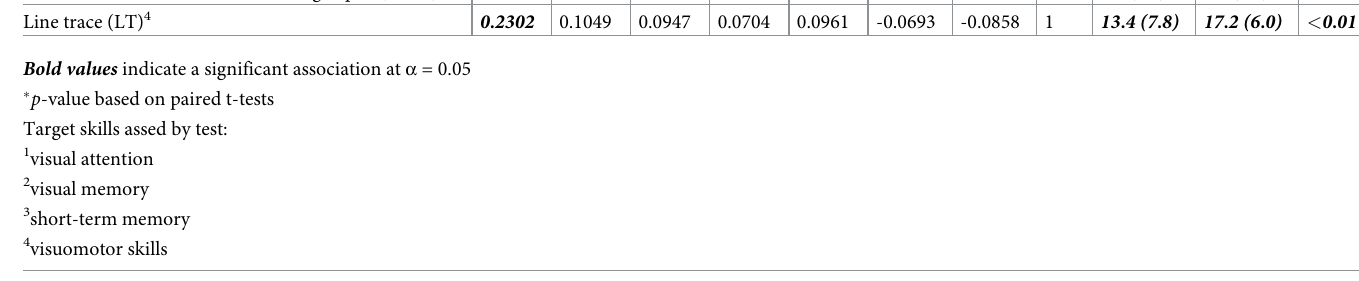
Results from pairwise tests of correlations between cognitive test scores and results from the paired t-tests of the association between test score and visit day are shown in Table 2. Most tasks were significantly correlated with at least one other task included in the battery of cogni- tive tests. Students achieved significantly higher scores on the second visit compared to the first visit for six of the eight cognitive tests, regardless of treatment condition. Table 2. Correlation matrix of cognitive test scores’ pairwise correlation coefficients and univariable associations between visit day and mean (standard devation) of cognitive test scores. Pairwise Correlation